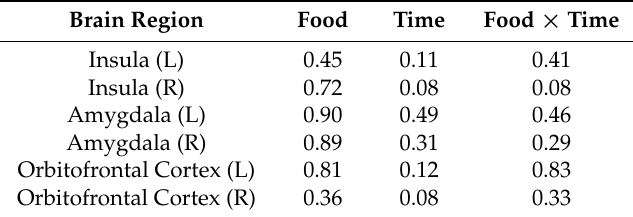
Table 4. Intervention effects on postprandial neural responses to visual food stimuli 1 .